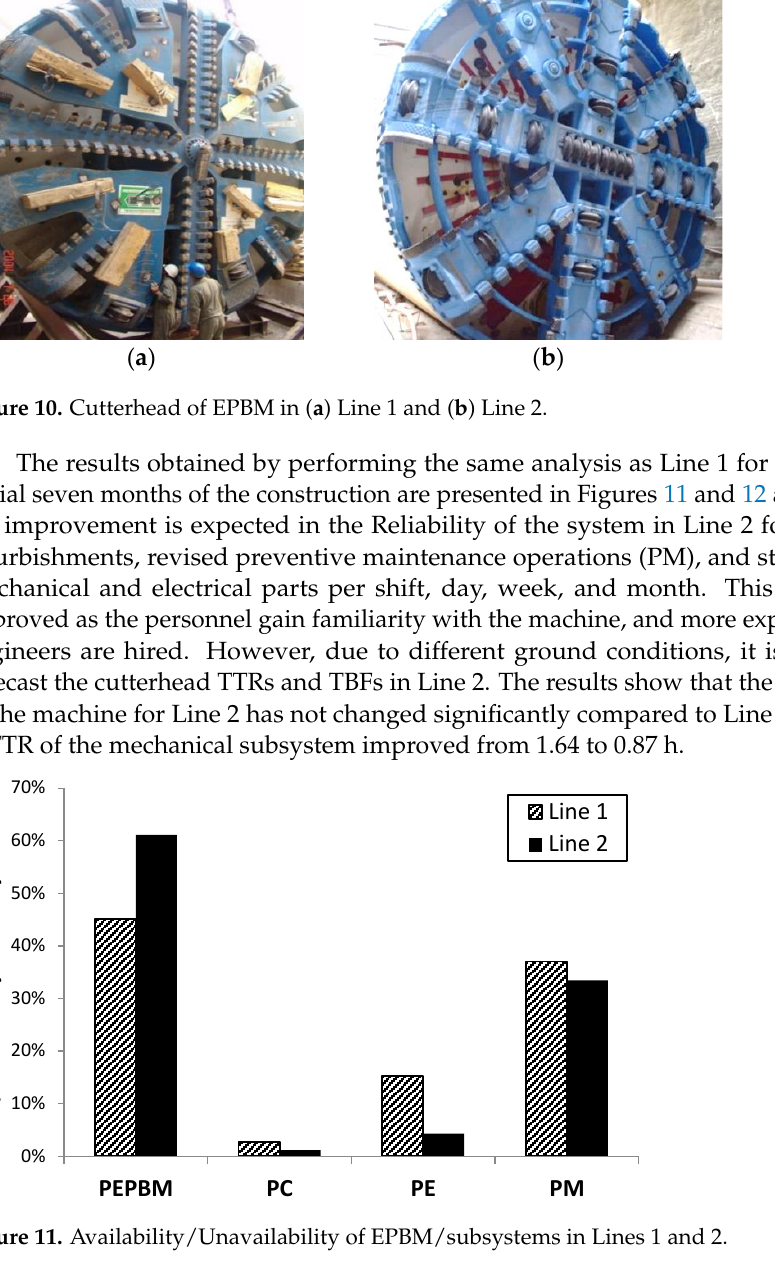
Table 9. Comparison of λ and μ of subsystems in Lines 1 and 2 .